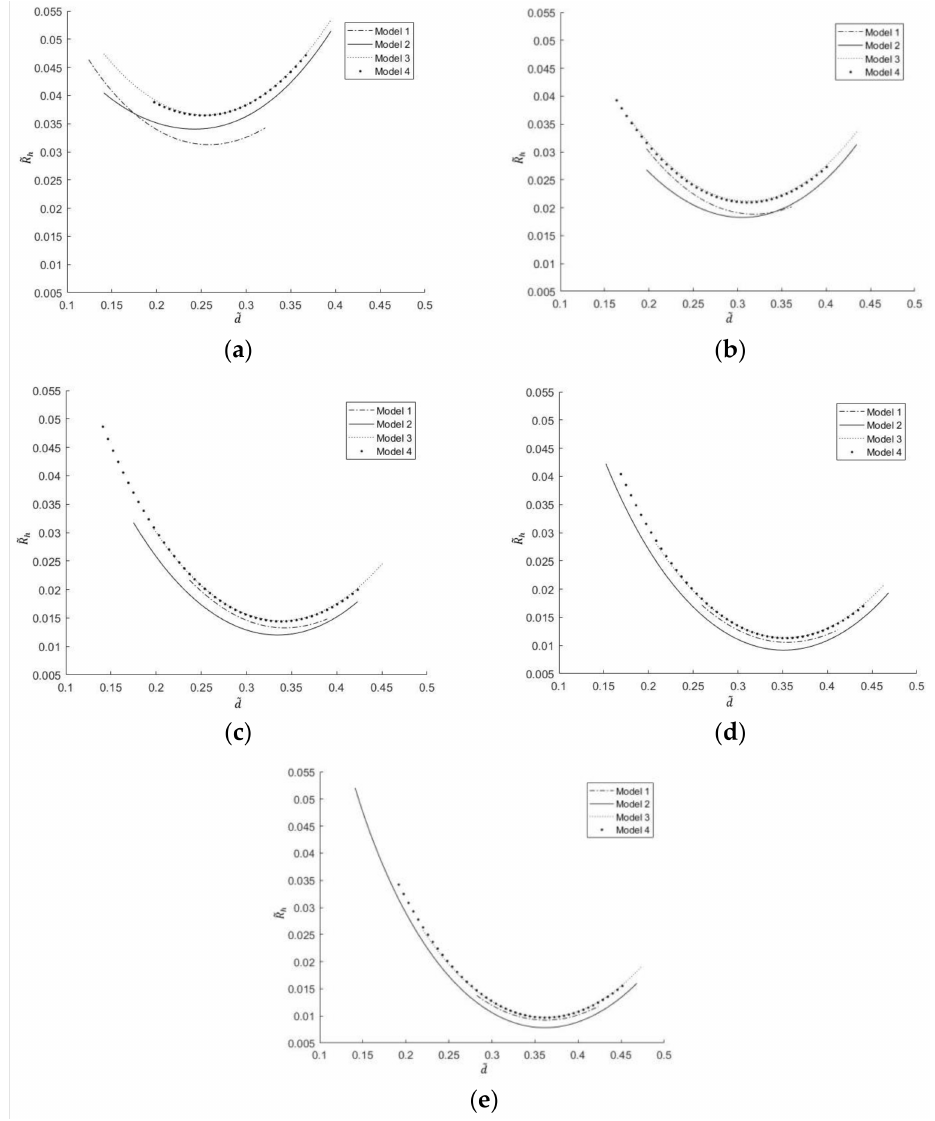
Figure 12. The influence of N and ϕ on (cid:101) R h and (cid:101) d when ϕ = 15%. Where subfigures ( a – e ) are N = 2–6